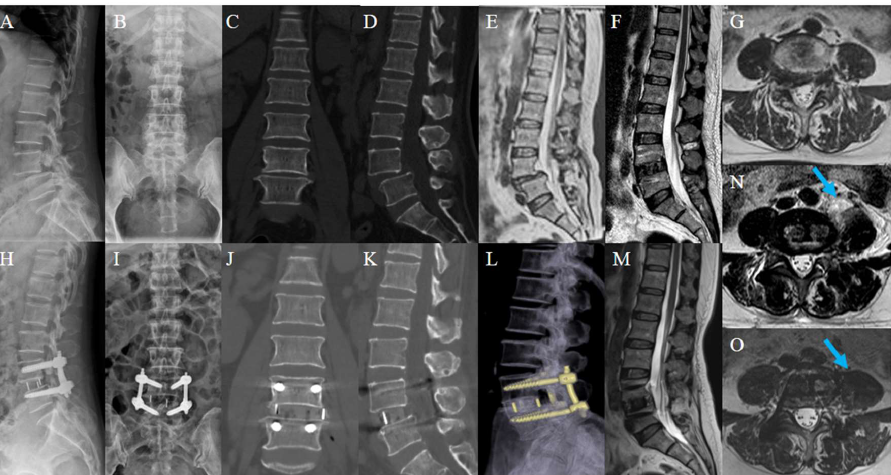
Figure 4. Typical case. A 55-year-old woman, presented with pain and numbness in the right lower extremity for 5 years; her condition worsened for 3 weeks. Preoperative lumbar X-ray ( A , B ); preoperative lumbar CT ( C , D ); preoperative lumbar MRI. Preoperative images showed the L4 spondylolisthesis and stenosis at L4-5 ( E , G ); postoperative lumbar X-ray showed L4 was reduced ( H , I ); postoperative lumbar CT showed the distraction of disc height ( J , K ); postoperative lumbar MRI showed satisfactory decompression and a huge swelling of the left psoas major (arrow) ( F , N ). Lumbar CT reconstruction and MRI at 1-year follow-up showed solid fusion with no cage subsidence ( L ). Swelling of the left psoas major reduced significantly and its area recovered (arrow) ( M , O ).